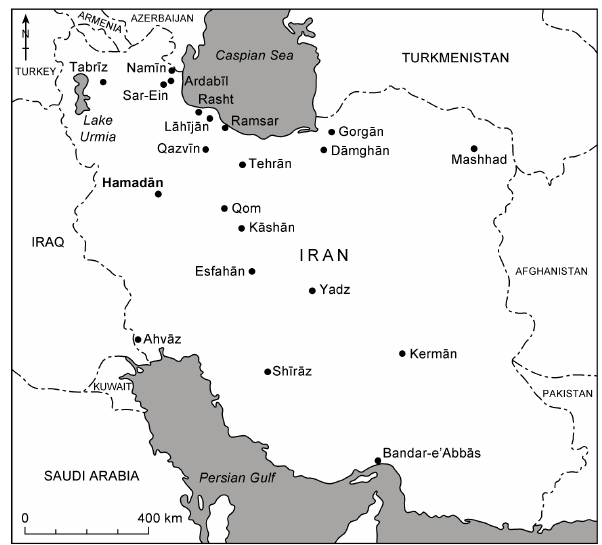
Fig. 1. Location map showing Hamadan in relation to the capital of Iran, Tehran, the high background radiation area of Ramsar and the towns discussed by Hadad et al.